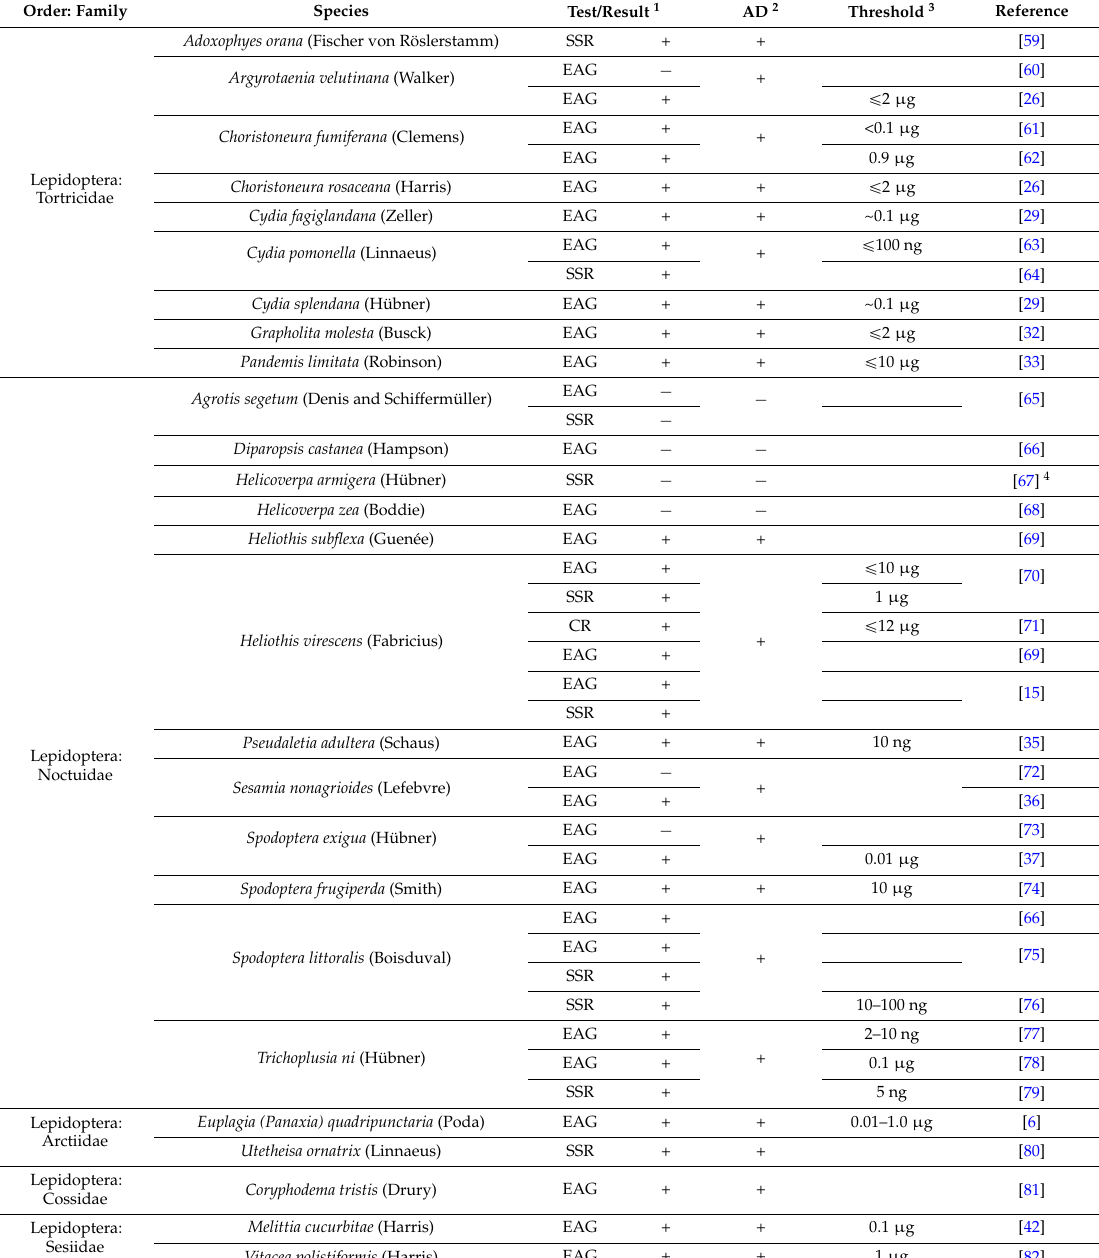
Table 2. Electro-physiological responses of females to conspecific sex